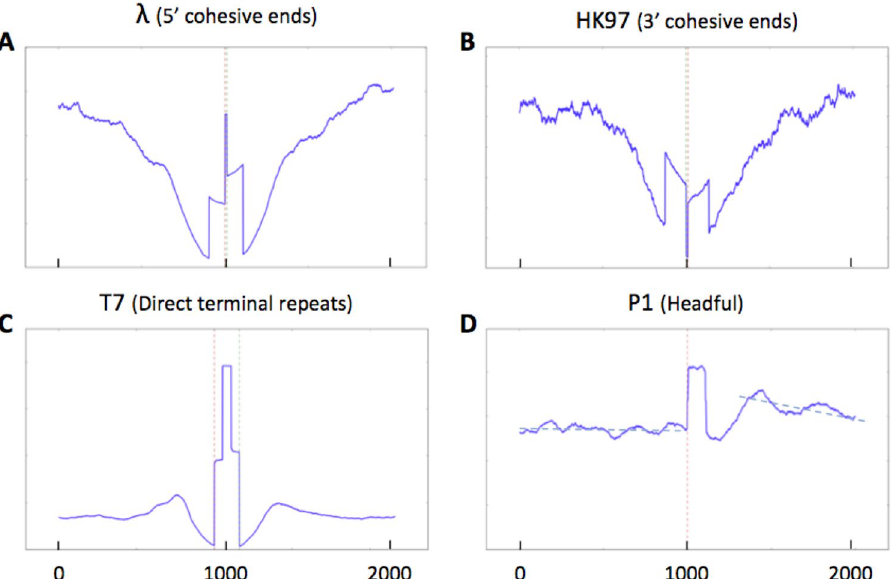
Figure 2. Sequence coverage at termini position. The sequence coverage around the termini identified by PhageTerm was plotted for the following phages: Lambda, HK97, T7 and P1. Exact termini positions are represented by dotted red line (Red: left; Green: right). Note the higher coverage obtained for phage P1 after the packaging